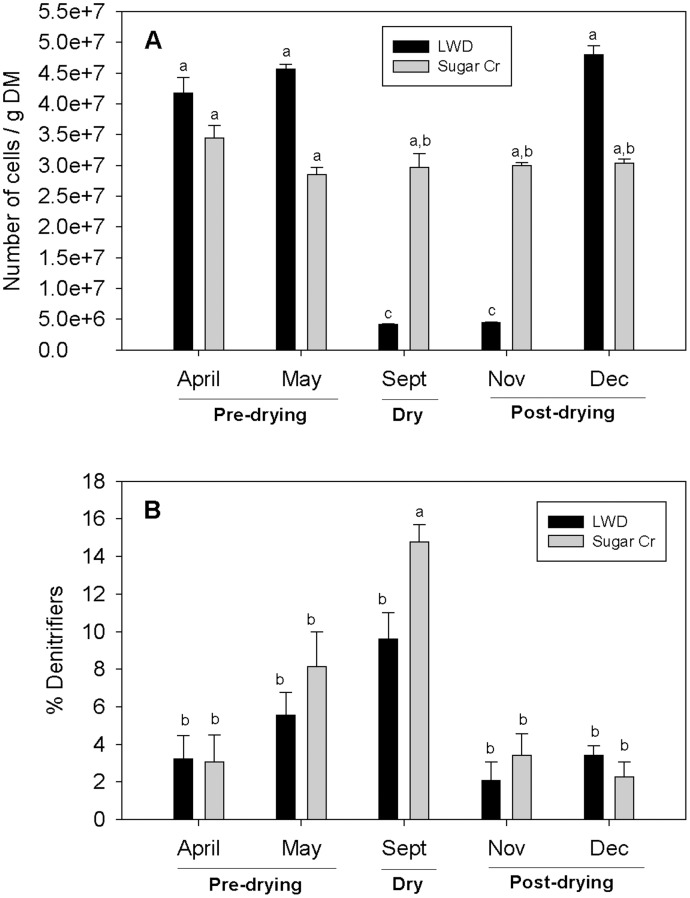
Bacterial abundance in study streams.(A) Mean total bacterial abundance (based on DAPI counts) by stream for each date. (B) Mean denitrifier abundance (ratio of nosZ: 16S rRNA copy number) by stream for each date. Pre-drying indicates LWD had flow; dry, no flow; post-drying, flow returned. Letters indicate significant differences (p<0.05) based on Tukey's post hoc multiple comparisons. Error bars indicate +1 SE.